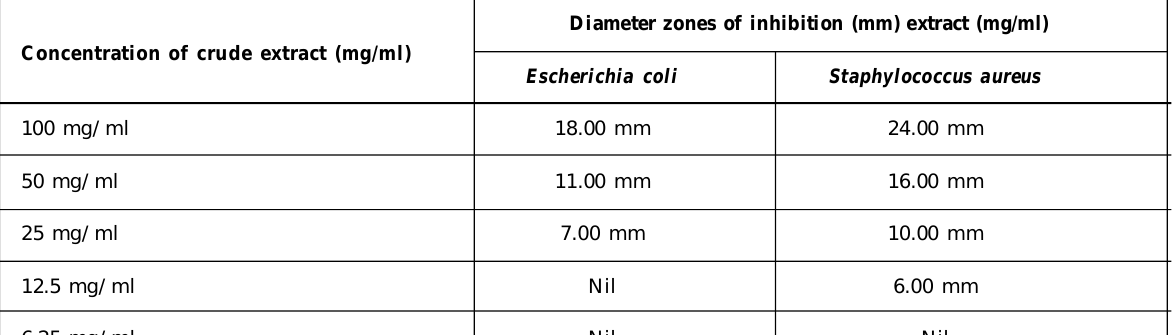
Concentration of crude extract (mg/ml)